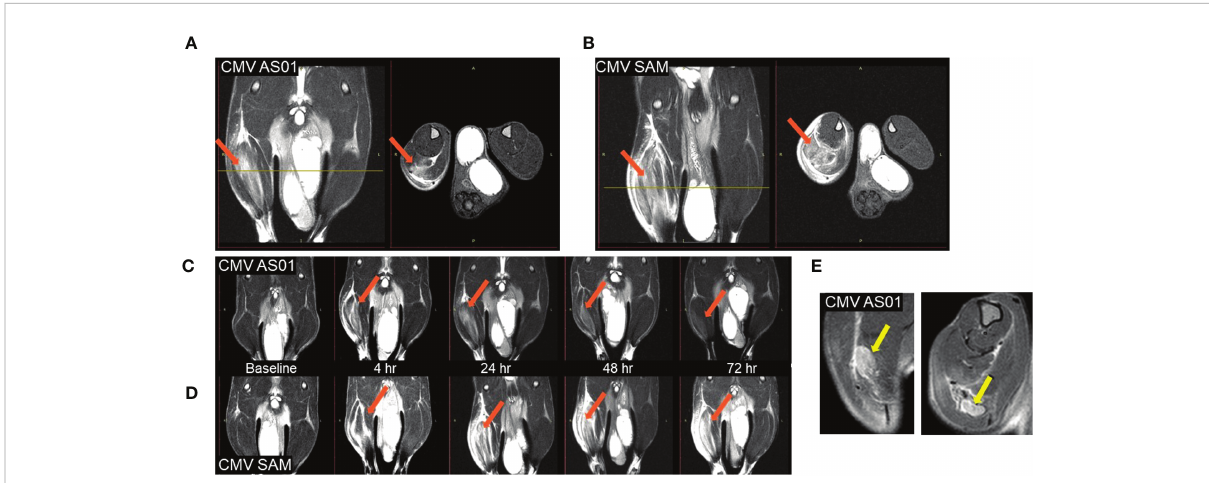
FIGURE 2 MR images of rat hindlimb at 24 hr post Prime vaccine injection. Coronal (left) and associated Axial (right) images (at level of yellow line slice indicator) for CMV AS01 (A) and CMV SAM (B) . Temporal response images for CMV AS01 (C) and CMV SAM (D) . Both Coronal (left) and Axial (right) images of the popliteal lymph node are identi fi ed (E) . Orange arrows indicate area of in fl ammation in hindlimb muscles following vaccination. Yellow arrows indicate popliteal lymph